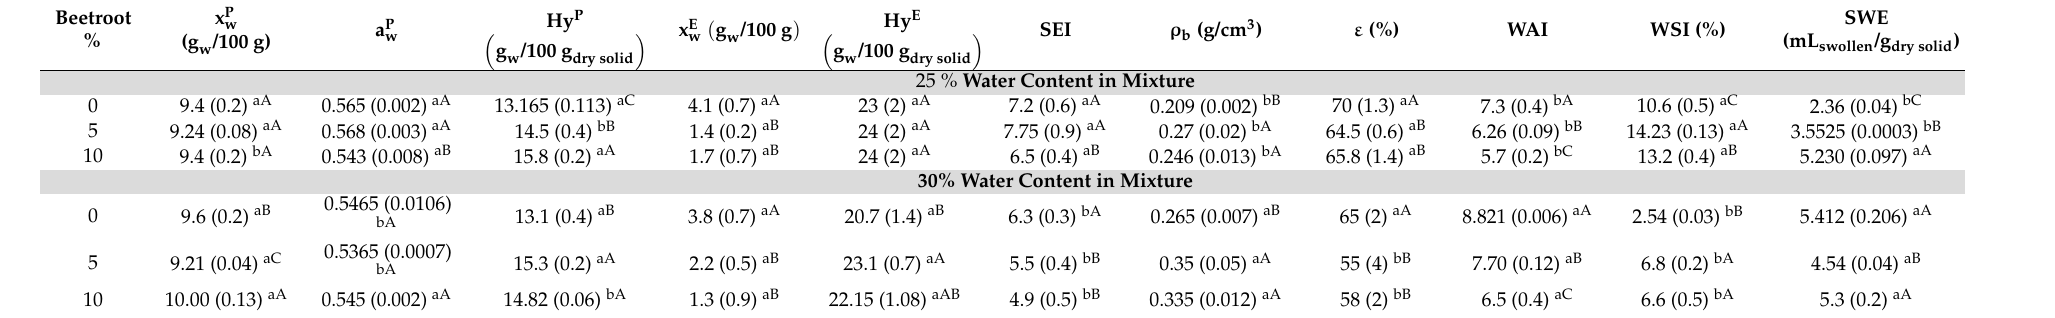
Table 2. Mean values (and standard deviations) of pellet water content (x P w ), pellet water activity (a P w ), pellet hygroscopicity (Hy P ), extrudate water content (x E w ), extrudate hygroscopicity (Hy E ), and section expansion index (SEI), bulk density ( ρ b ), porosity ( ε ) water absorption index (WAI), water solubility index (WSI), and swelling index (SWE) of expanded